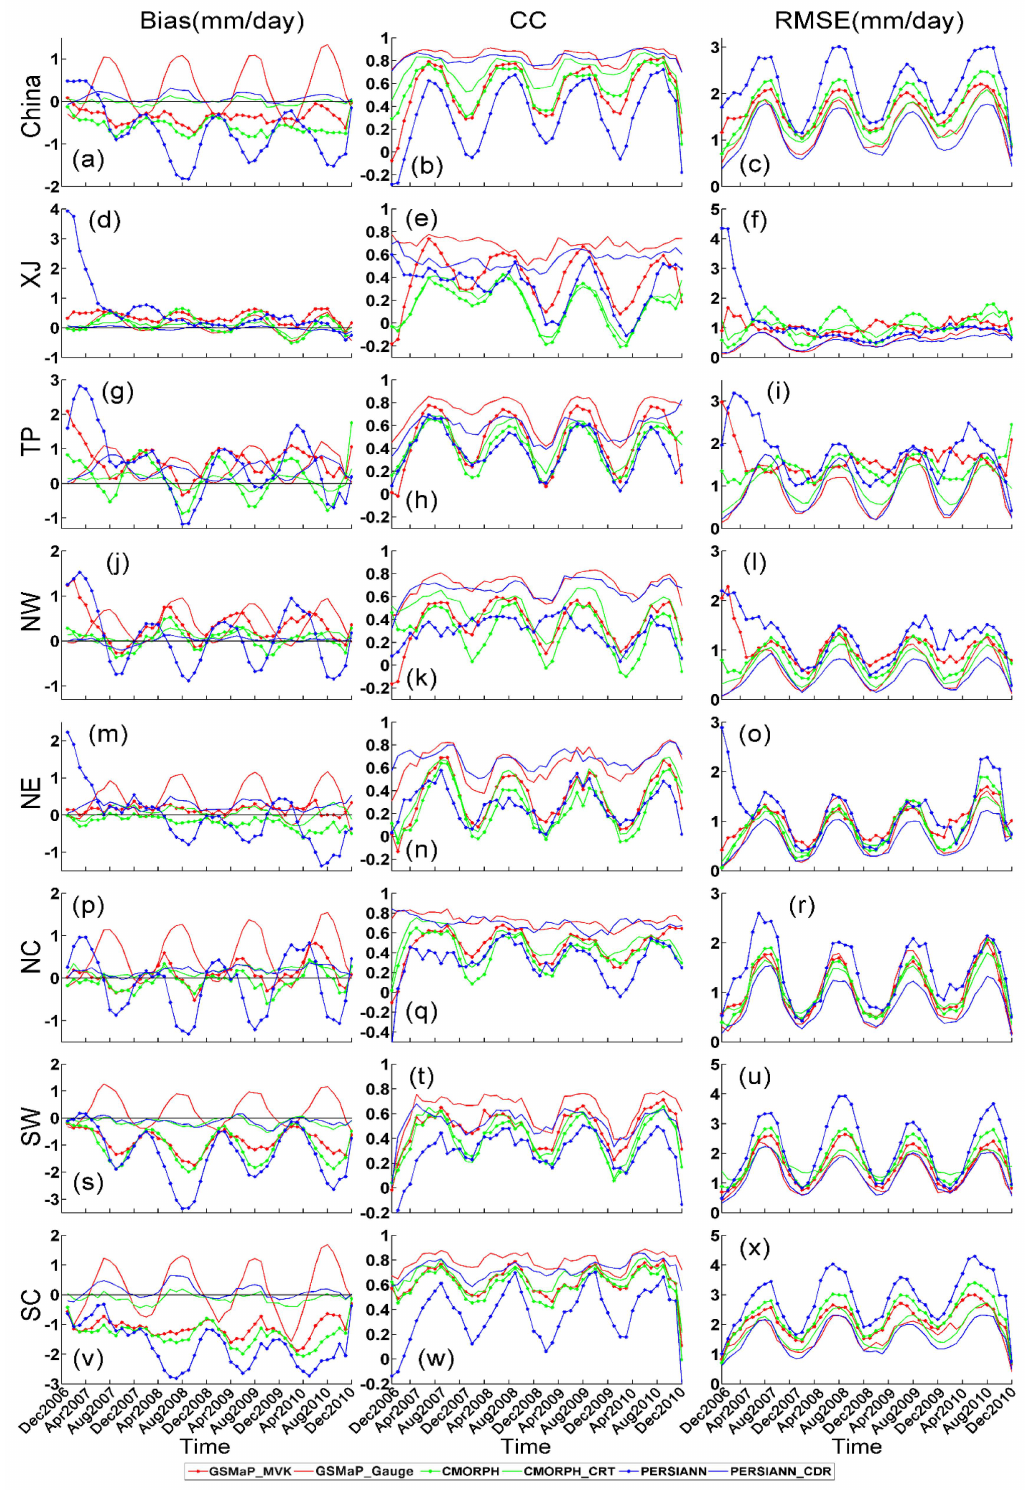
Figure 7. Monthly series of Bias in the left column panels, Correlation Coefficient (CC) in the middle column panels, root-mean-square error (RMSE) in the right column panels between various products and CPAP over ( a – c ) continuous China and seven sub-regions for ( d – f ) XJ; ( g – i ) TP; ( j – l ) NW; ( m – o ) NE; ( p – r ) NC; ( s – u ) SW; ( v – x ) SC on 0.25 ˝ lat/lon grid box. Only the cells where there is at least one reporting gauge in CPAP and both CPAP and the satellite-based precipitation estimates are above zero have been selected for